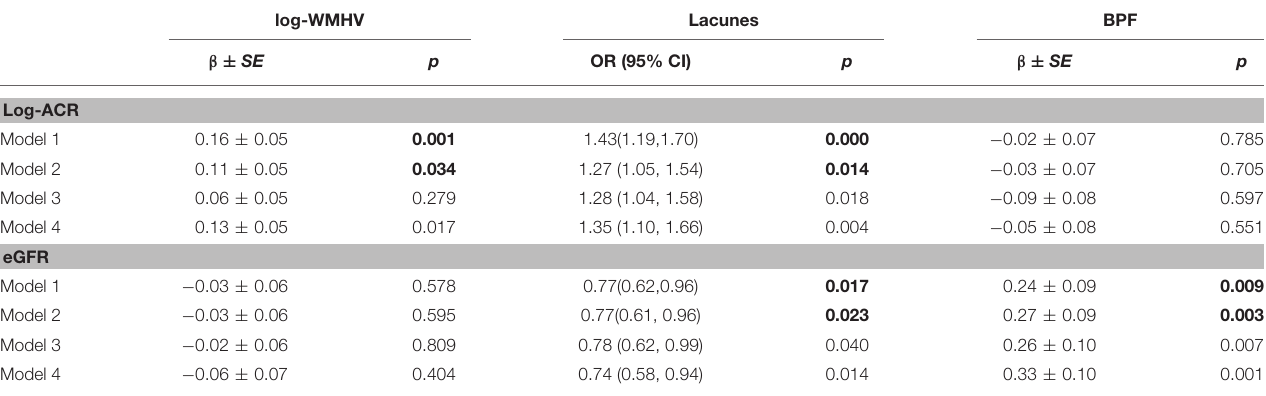
Model 1: adjustment for age and sex. Model 2: as in Model 1, with additional adjustment for vascular risk factors (hypertension, diabetes, hyperlipidemia, current smoking, and BMI). Model 3 and Model 4: as in Model 2, with additional adjustment for baPWV and carotid plaque separately. Analyses involving white matter hyperintensity volume were additionally adjusted for intracranial volume. ACR, albumin-to-creatinine ratio in urine; eGFR, estimated glomerular filtration rate; WMHV, white matter hyperintensity volume; BPF, brain parenchymal fraction.